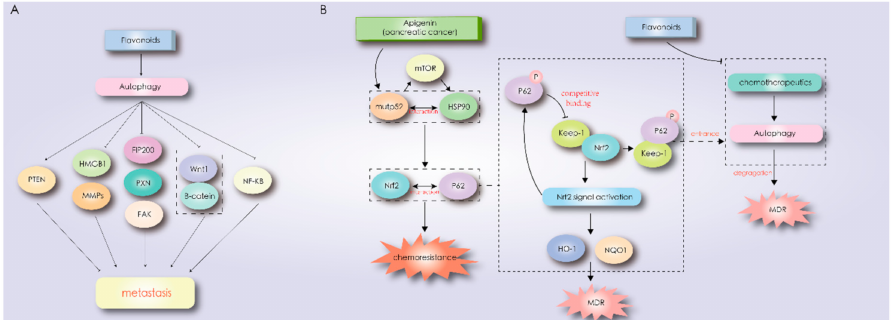
Figure 3. Flavonoids monitor autophagy affecting metastasis and multidrug resistance (MDR). ( A ) Flavonoid-induced autophagy mediates metastasis of tumor cells by the inhibition of the Wnt/ β - catenin and NF- κ B signal pathway and upregulation of the metastasis-related protein expression, and inhibits neovascularization via promotion of the tumor suppressor gene PTEN. ( B ) In PaCa44 cells, mutant p53 stabilizes through its interaction with HSP90, which can be upregulated by promoting mTOR activation, activating the positive feedback loop between Nrf2 and p62, and thereby inducing chemotherapy resistance to apigenin. In tumor cells, when autophagy is compromised, the com- petition between p62 accumulation and nuclear factor erythroid 2 (Nrf2) combination with keap-1 leads to the nuclear translocation of Nrf2 dissociation, promoting continuous activation of the Nrf2 signal pathway and p62 accumulation, while the p62/kelch-like ECH-associated protein 1 (Keap-1) complex is isolated in autophagosomes and degraded by autophagy. Some effective chemothera- peutic drugs have been found to produce drug resistance by inducing the autophagy of tumor cells, yet flavonoids combined with these chemotherapeutic drugs can block this pathway through the inhibition of